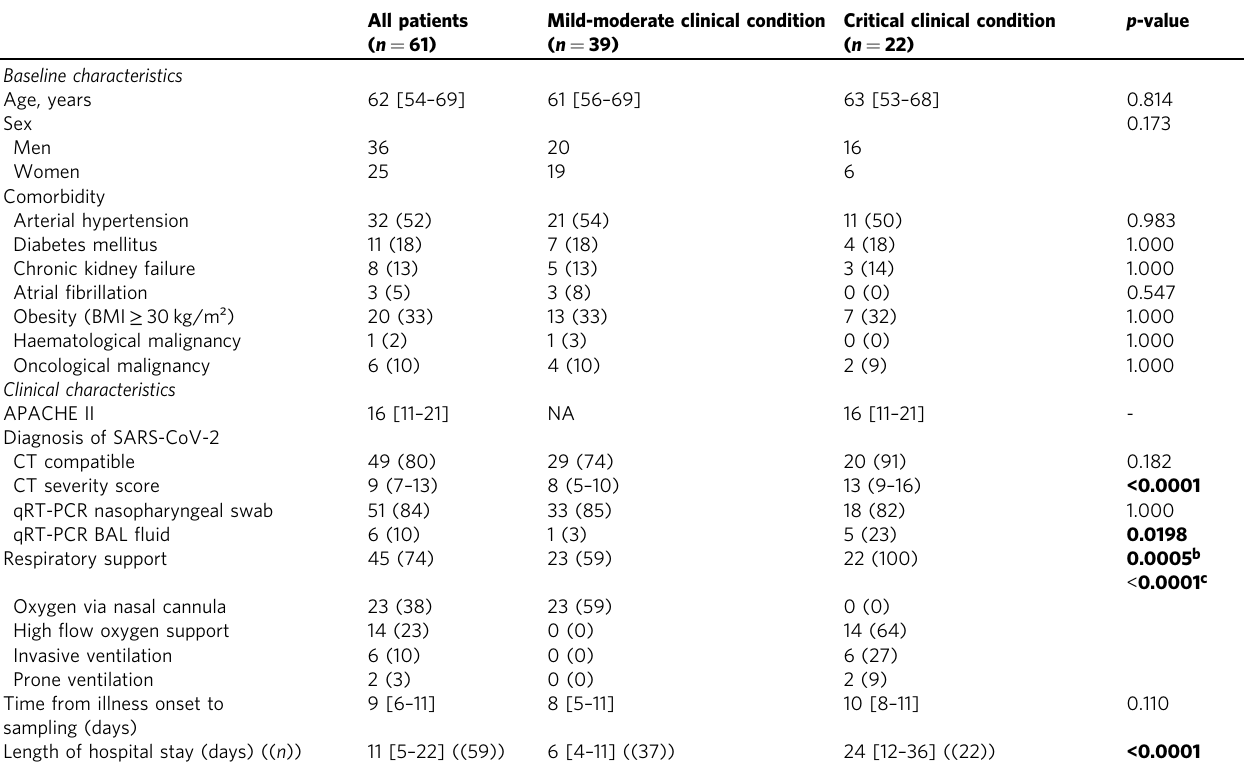
Table 1 Demographics and characteristics of patients infected with